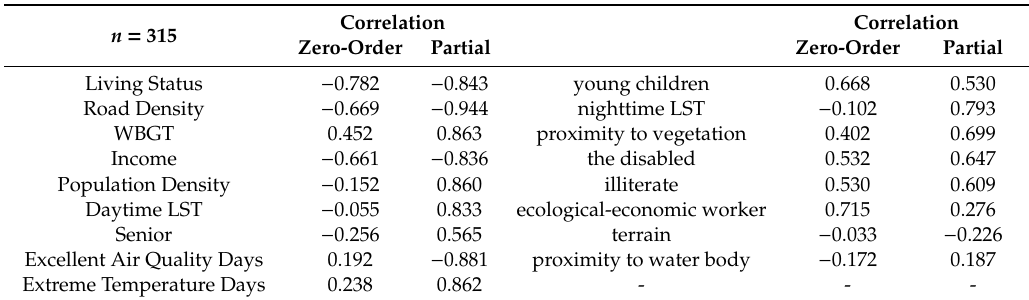
Table 3. Stepwise multiple linear regression correlation coe ffi cient and the partial correlation coe ffi cient between HVI and introduced variables.